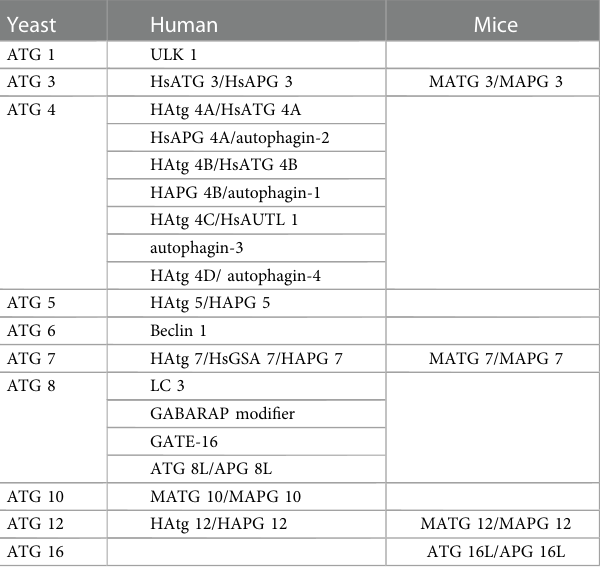
TABLE 1 Comparison of autophagy-related genes in yeast, human and